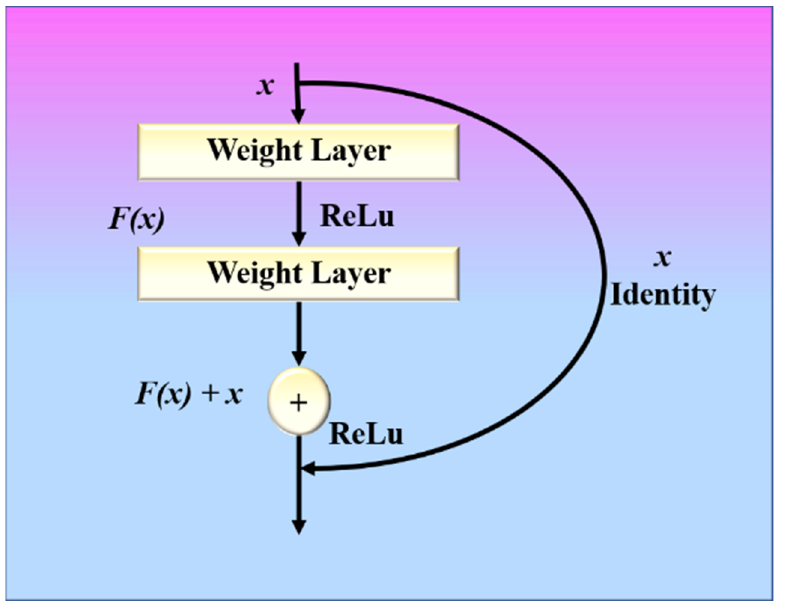
Figure 6. ResNet with residual block.